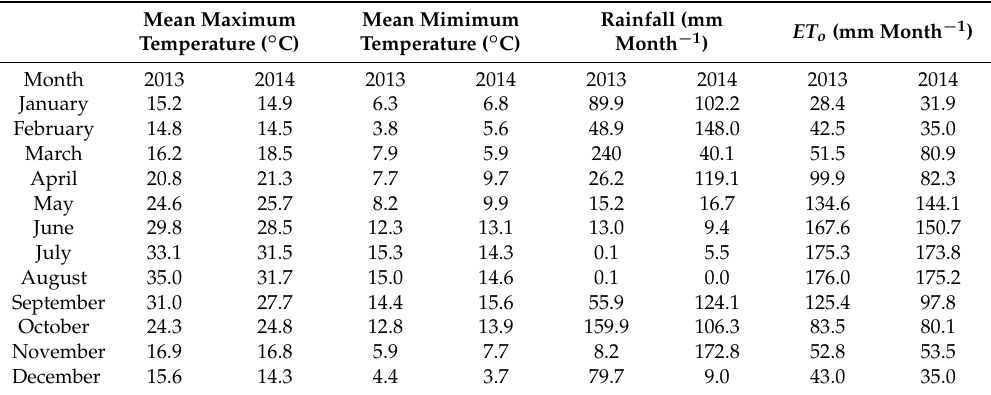
Table 1. Summary of the monthly values of maximum and minimum temperatures ( ◦ C), rainfall (mm month − 1 ), and reference evapotranspiration (mm month − 1 ) for the two study